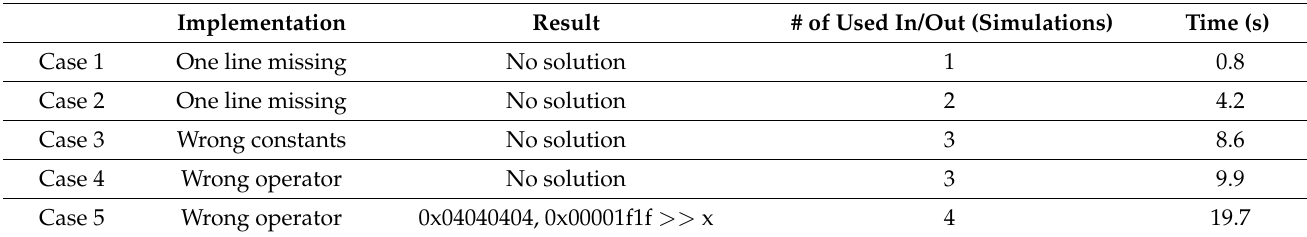
Table 2. Experimental results with five cases.